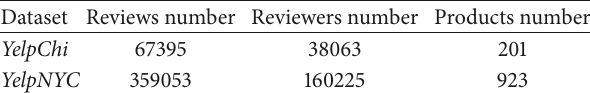
Table 5: The distribution table of reviews, products, and reviewers in